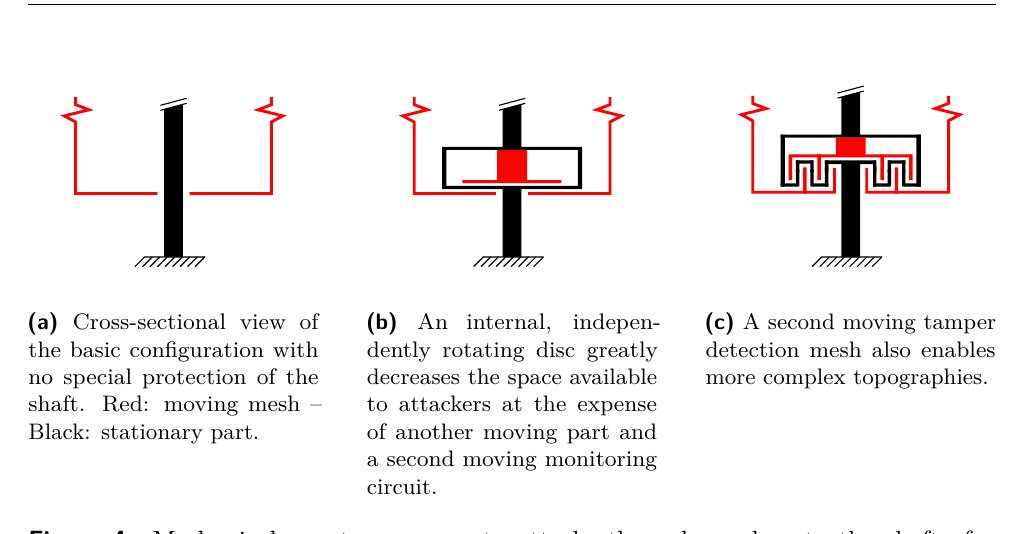
Figure 4: Mechanical countermeasures to attacks through or close to the shaft of a fixed-axis rotating